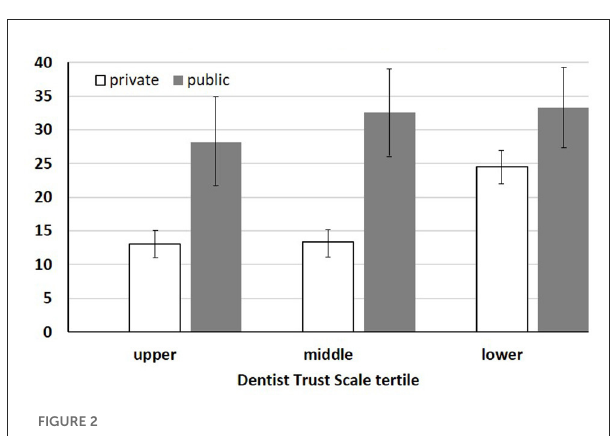
FIGURE2 Percentage of OHIP-14 impact (% ±